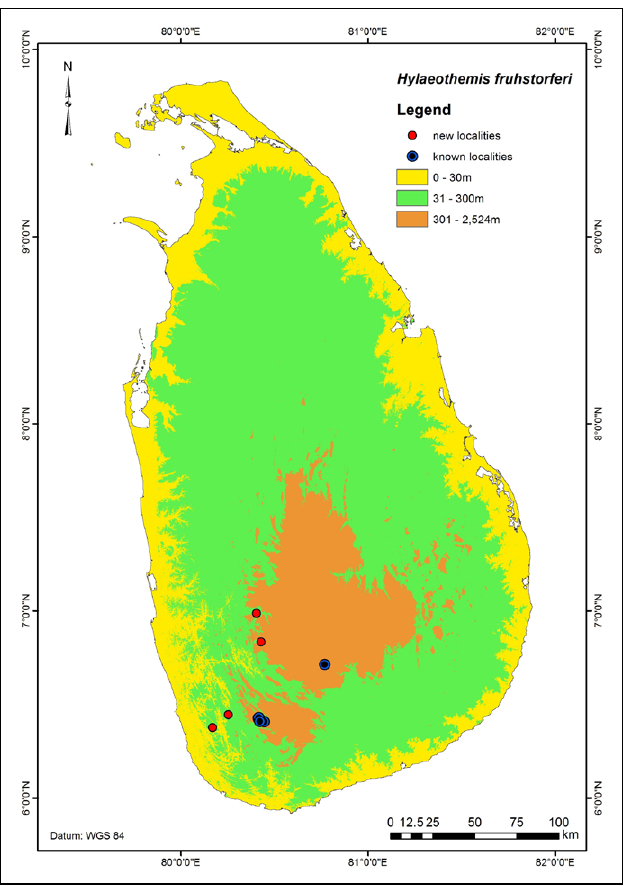
Figure 15. Hylaeothemis fruhstorferi ♂ .